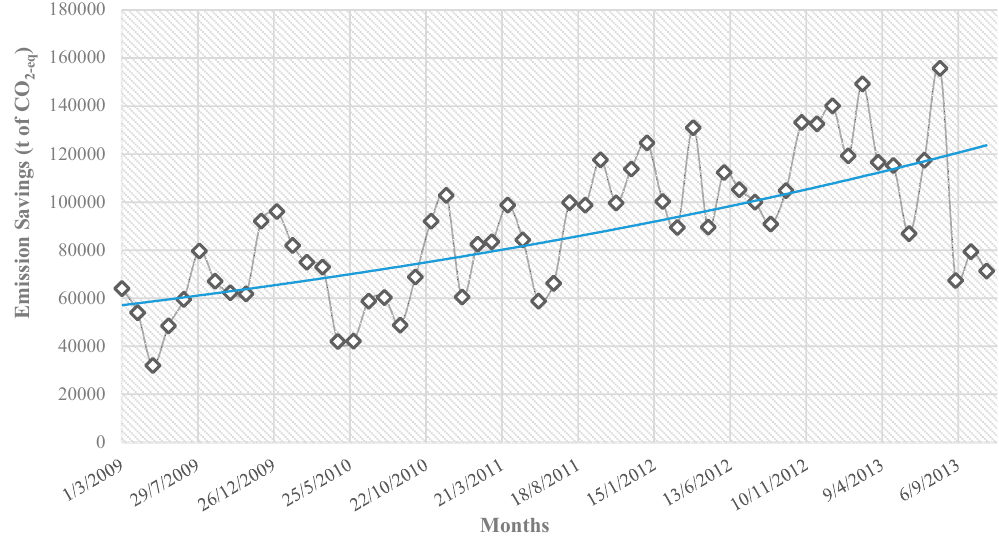
Figure 13. CO 2 emissions avoided owing to lignite-fueled generation offset by the wind RES-E generation from FiTs in Greece during the period 2009 to 2013.